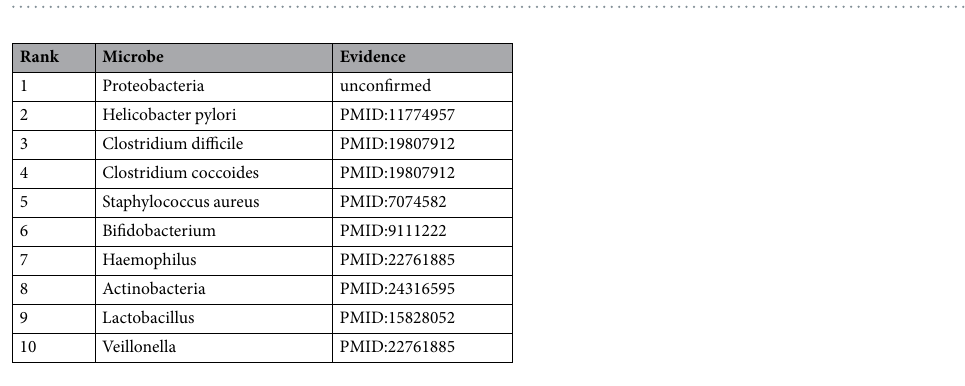
Table 2. In the case study of colorectal carcinoma, 9 out of top-10 predicted microbes have been supported by literature